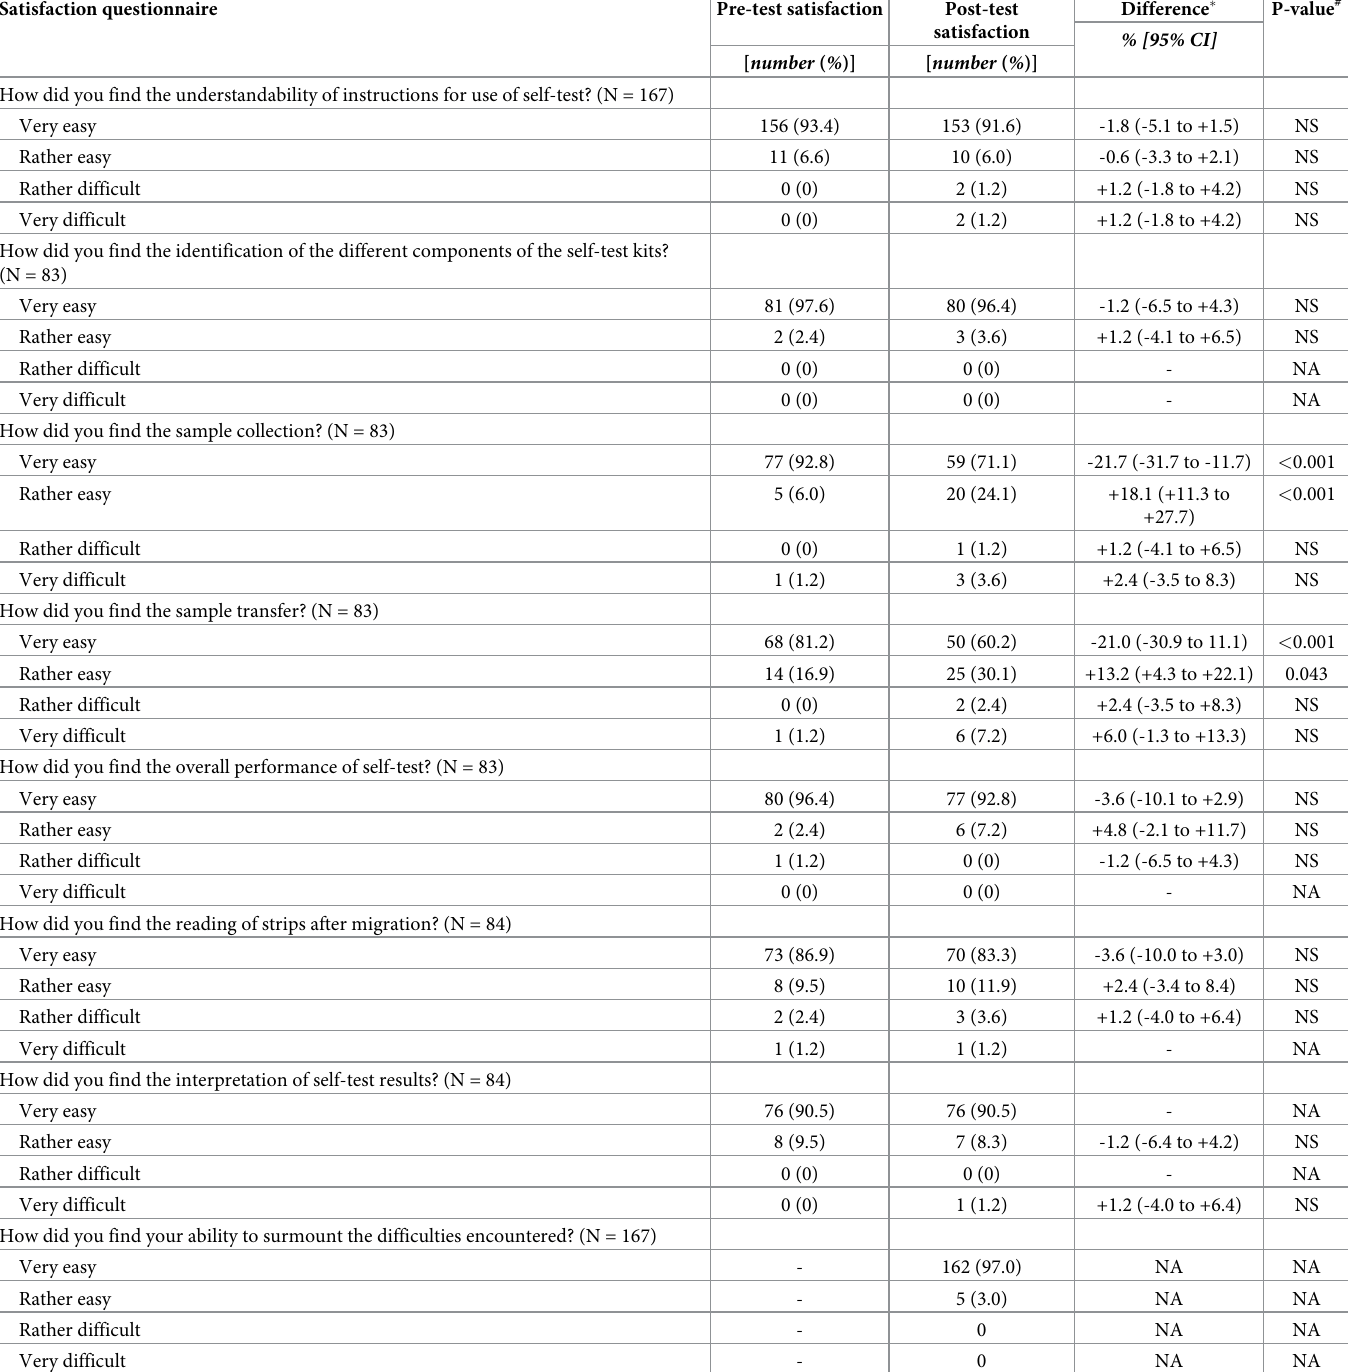
Table 4. Items and results of the pre-test and post-test satisfaction questionnaire and concerning the instruction notice (substudy 1), the performing of the Exacto COVID-19 self-test (Biosynex Swiss SA) (substudy 2), and the interpretation of test results (substudy